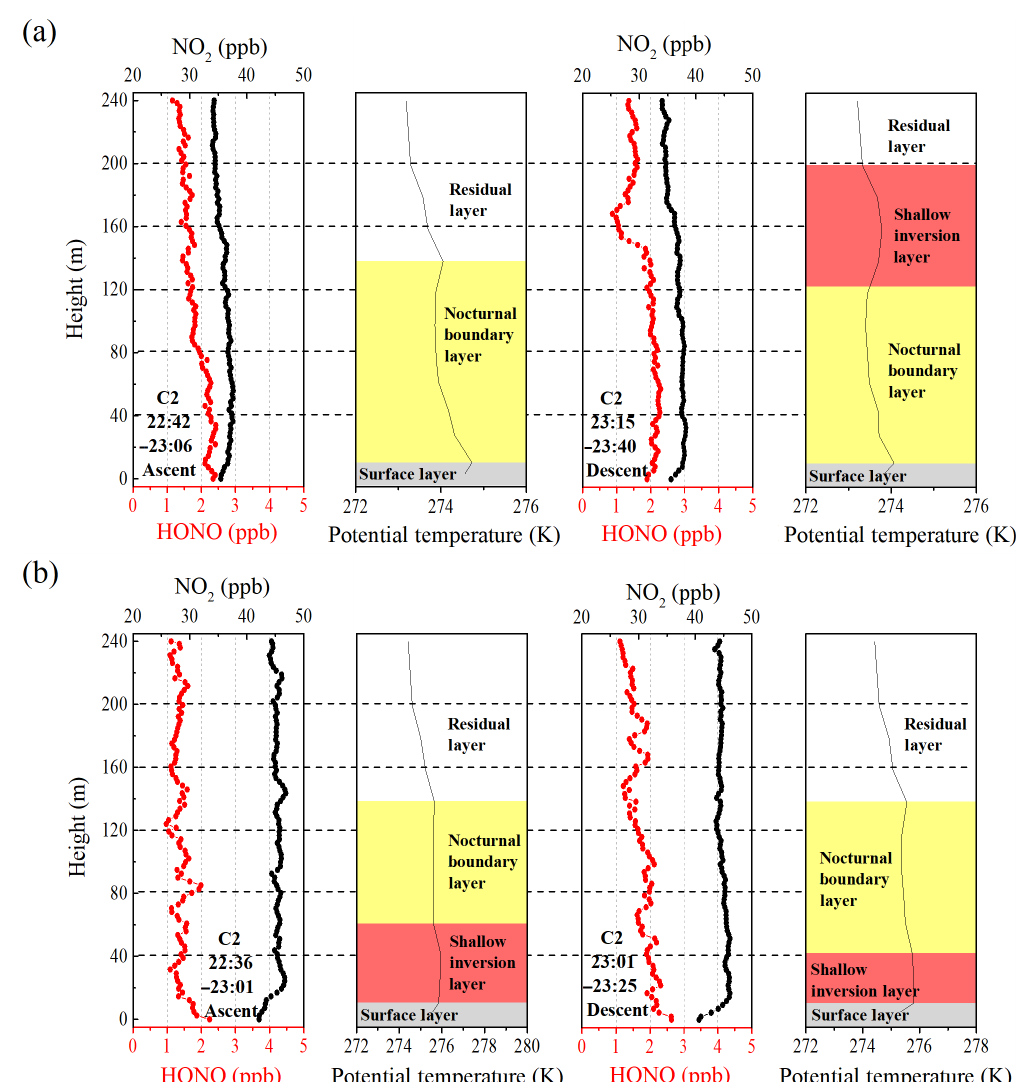
Figure 4. Nocturnal vertical profiles of HONO, NO 2 , and the potential temperatures during the ascent and descent of the container on (a) 9 and (b) 10 December. The time in the figure corresponds to the measurement time of the vertical profile of the HONO and NO 2 . The different colored shaded region indicates the nocturnal small-scale stratification (surface layer, nocturnal boundary layer, shallow inversion layer, and residual layer). The heights of the surface layer, the shallow inversion layer, the nocturnal boundary layer, and the residual layer are denoted by grey shaded regions, pink shaded regions, yellow shaded regions, and white shaded regions,